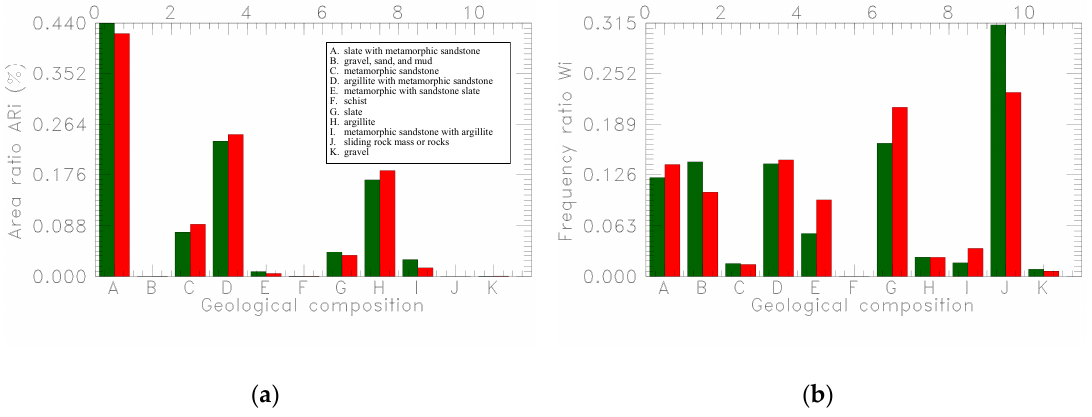
(red bars). (red bars).